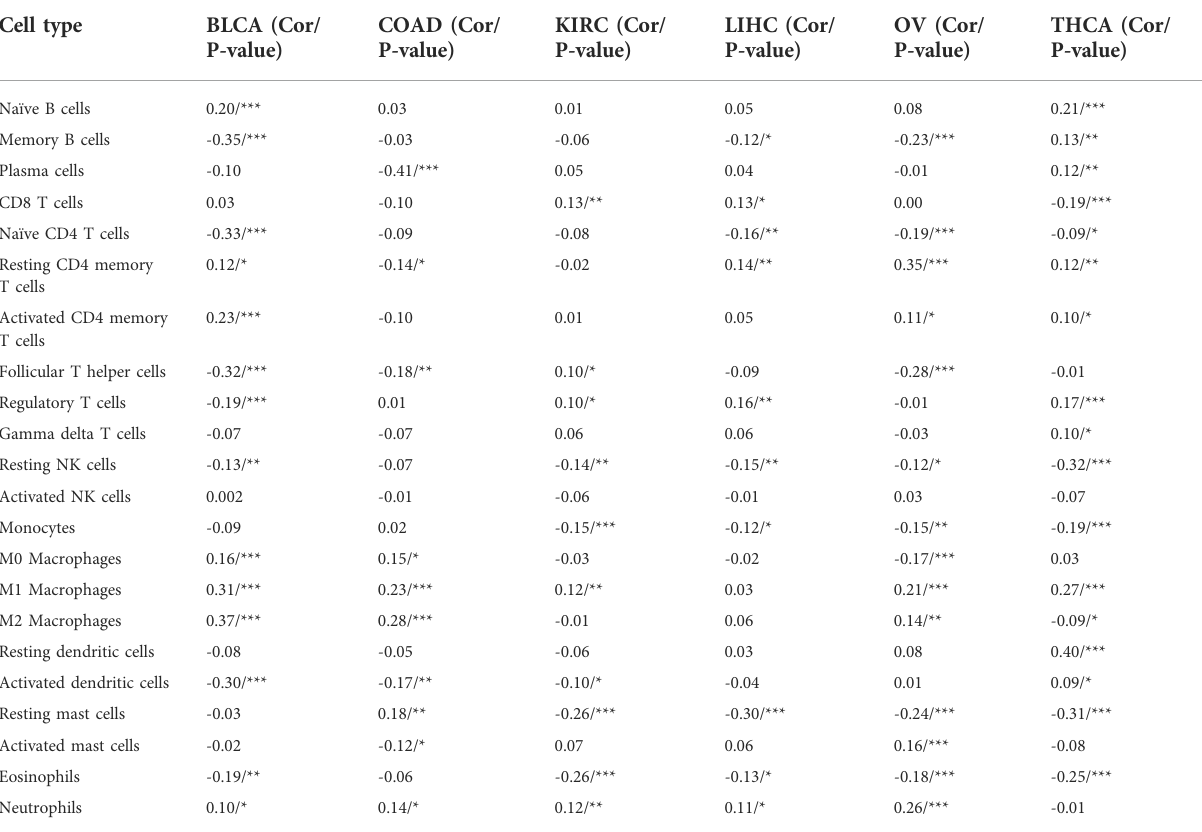
TABLE 1 Relationship between NNMT expression and immune cell in fi ltration in different